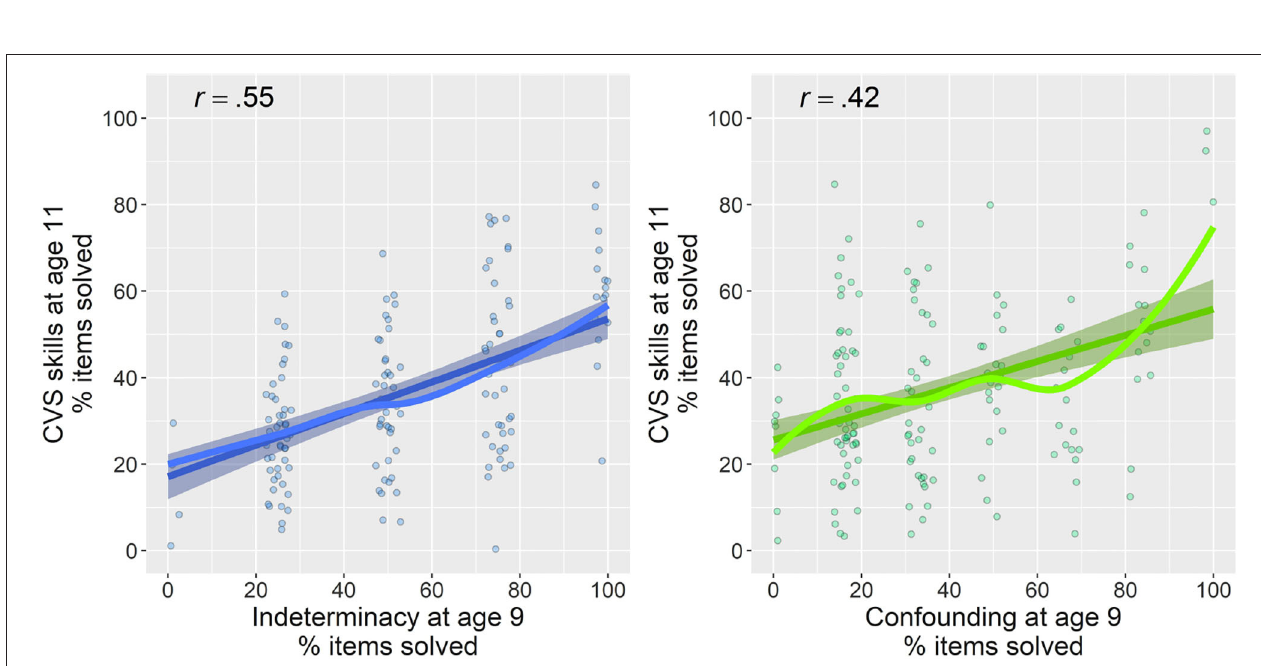
FIGURE 4 | Relations of indeterminacy (left) and confounding (right) at average age 9 with later overall CVS skill at average age 11. Percentage of items solved are plotted for all measures. Lines with 95% confidence band indicate linear trend, and lines without confidence bands indicate nonlinear (smooth) associations. Points are jittered for a better readability of scatterplots. Pearson correlations between variables are displayed in upper-left of each plot.